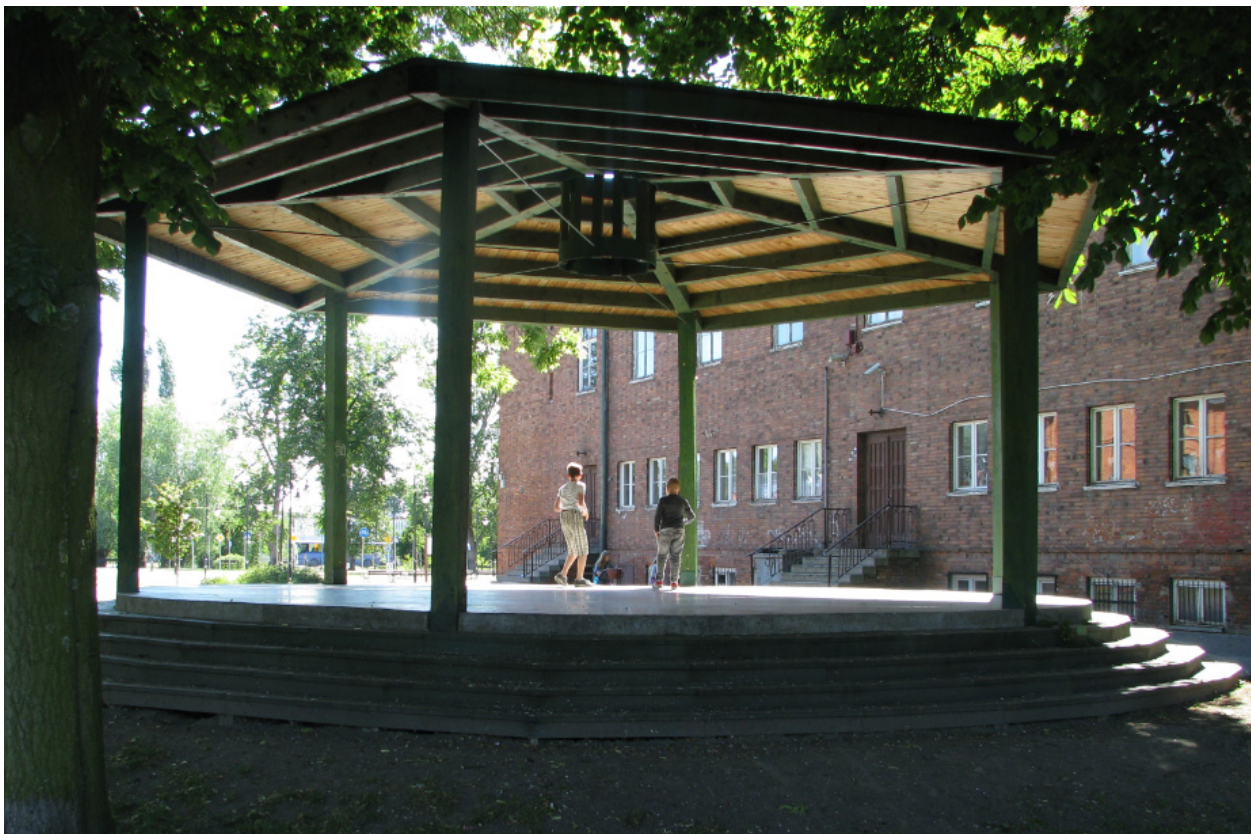
Figure 4. Stage in Nowy Dwór Gda ń ski, Poland (Photo by Alicja K. Zawadzka, 11 June 2016).